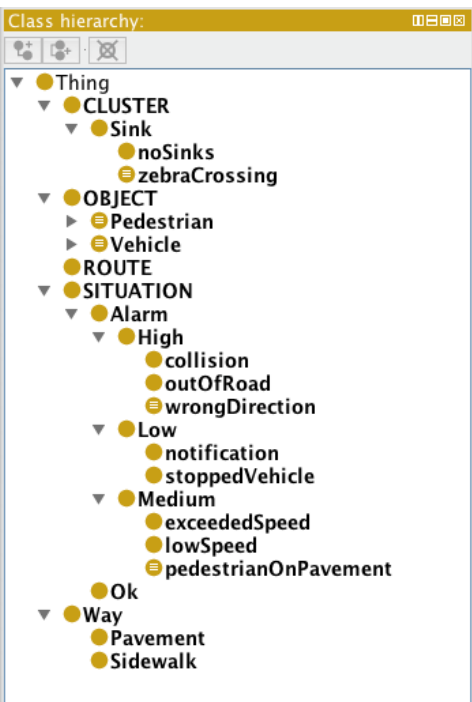
Figure 4. Hierarchical structure of